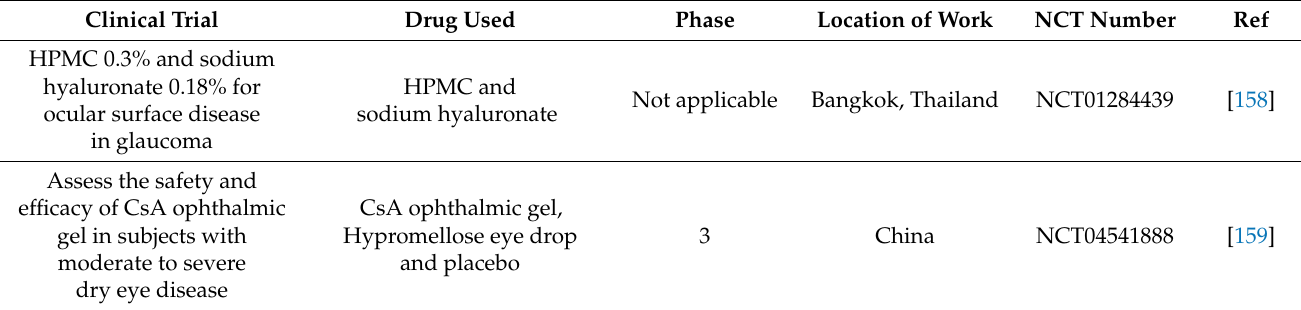
Table 4. Clinical trials based on various cellulosic polymers used in ocular drug delivery. Clinical